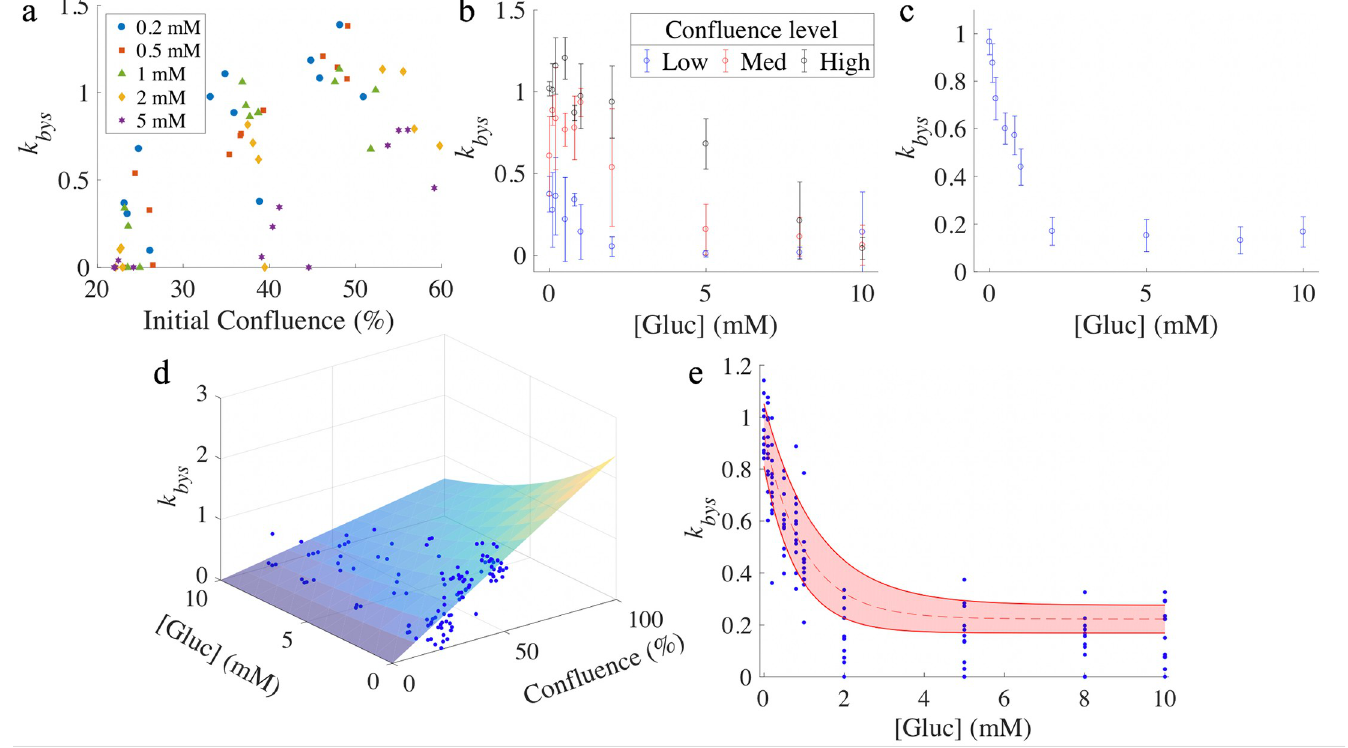
Fig 3. Relationship between bystander effect death rate ( k ) and initial conditions. Panel a presents estimates of the death rate due to the bystander effect, k bys function of different initial confluence and glucose levels for BT-474 cells. For each glucose level, k bys increases with higher initial confluence, where the lowest initial glucose level increases k the most. Panel b indicates that k increases with higher initial confluence and decreases with higher initial glucose level for the BT-474 line. bys bys (Error bars were calculated from the four wells with similar initial conditions.) Panel c shows that k bys decreases with higher initial glucose level for the MDA-MB-231 cell line. (Error bars were calculated from the twelve wells with same initial glucose level.) Panel d shows the parameter surface for the BT-474 cell line, where k displayed as function of initial confluence and glucose level, with blue dots representing calibrated estimates of k bys . Panel e indicates how k bys decreases with initial glucose level for the MDA-MB-231 line, with shaded area between solid red curves showing the 95% confidence interval. The blue dots represent the calibrated estimates of k . The fitted surface and curve in panels d and e, respectively, is used to assign k as a function of initial confluence and glucose concentration in the validation bys bys data set. (Fig 3C), with a partial correlation coefficient of -0.72 (p < 10 − 4 ). For the low (36.9 ± 1.0%), intermediate (56.2 ± 1.4%), and high (71.9 ± 1.0%) initial confluences, there are significant